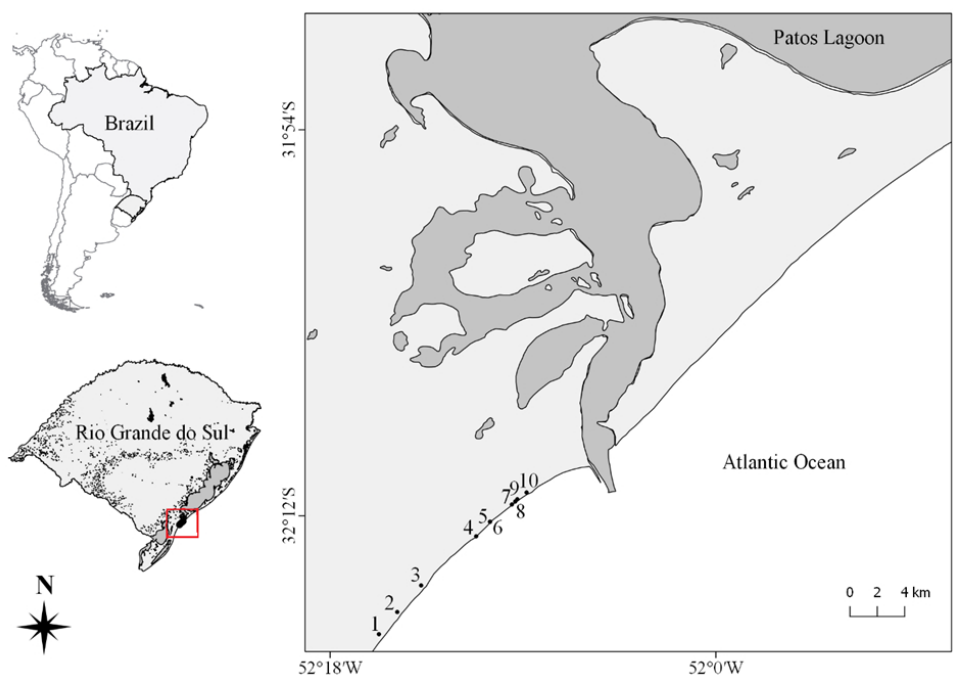
Figure 1. Location of the 10 studied coastal streams in the Coastal Plain of Rio Grande do Sul State,